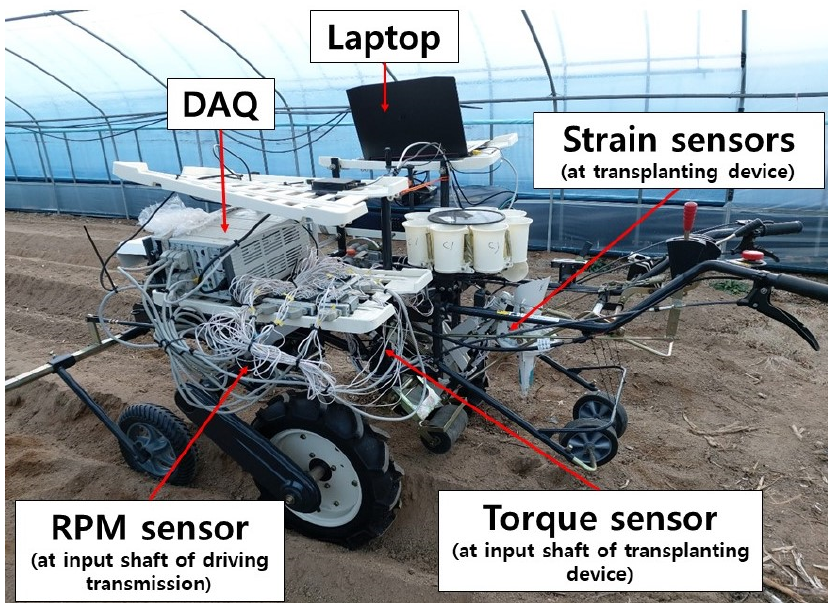
Figure 5. Measurement system for the four-bar-link vegetable transplanter.